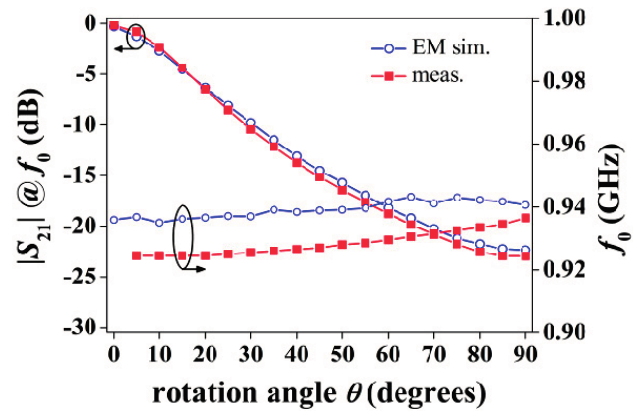
Figure 15. Simulated and measured transfer function of the sensor